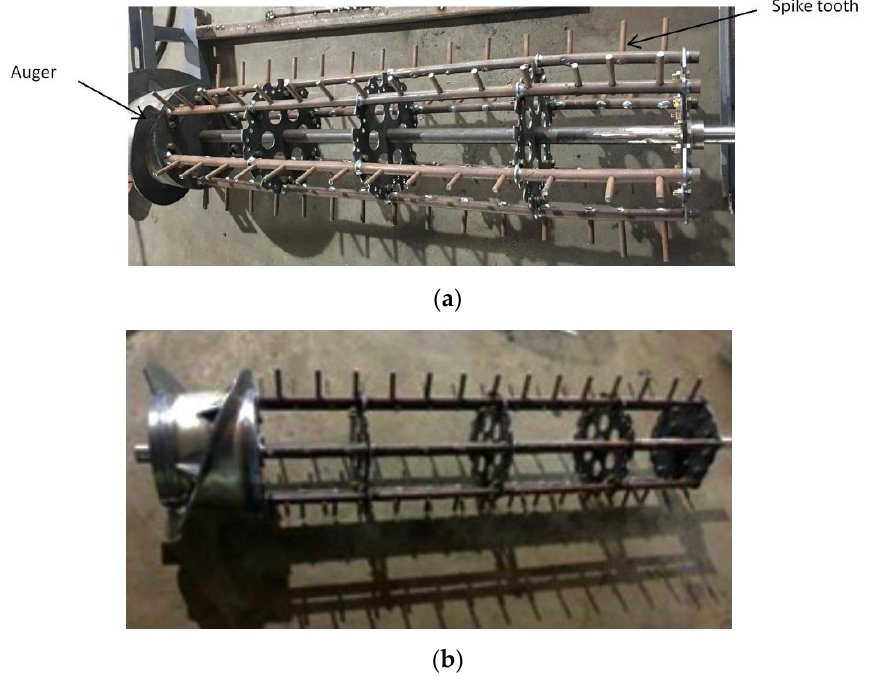
Figure 2. Longitudinal axial flow threshers: ( a ) Conical thresher and ( b ) cylindrical thresher.